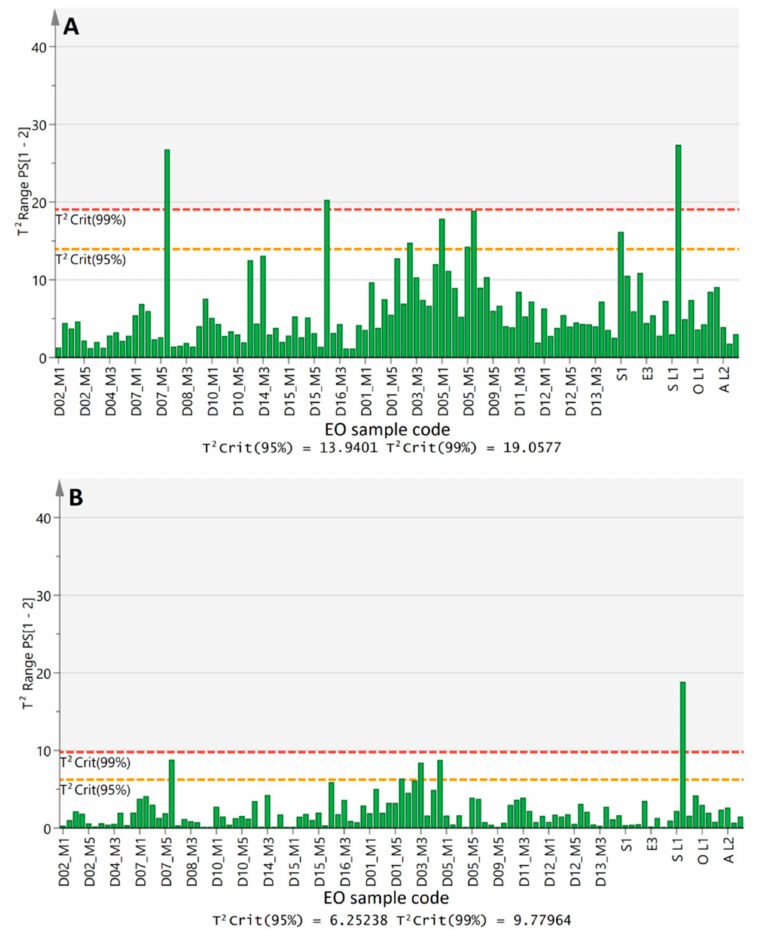
Figure 5. Hotelling’s T 2 plots displaying the predicted variance of commercial bay laurel EOs from the one-class model of reference EOs explained by six PCs ( A ) and two PCs ( B )